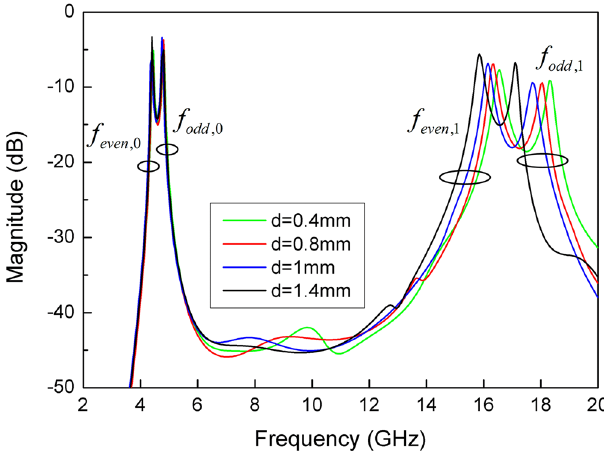
Figure 7. The simulated resonant modes curves of SSLSIR with different depth d of slit line.